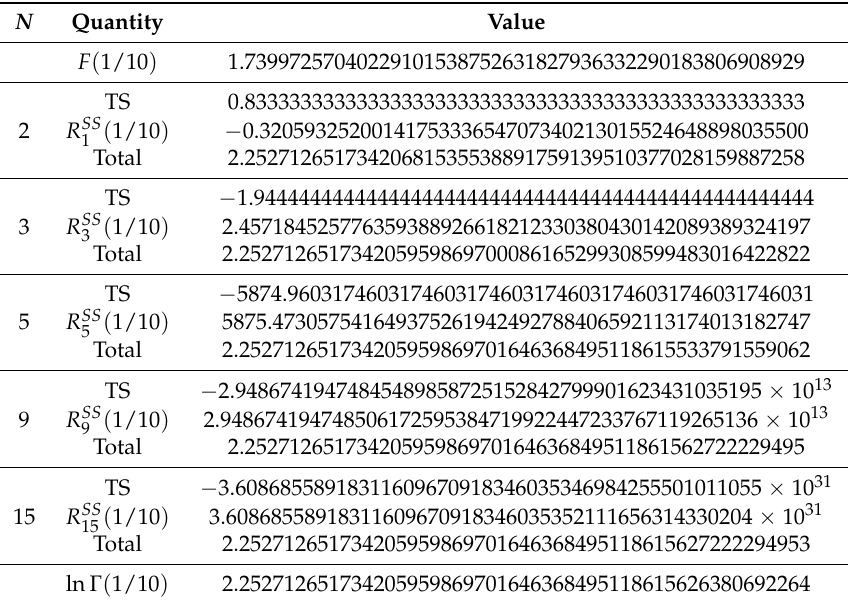
Table 2. ln Γ ( 1/10 ) via (35) for various values of the truncation parameter, N . N Quantity Value F ( 1/10